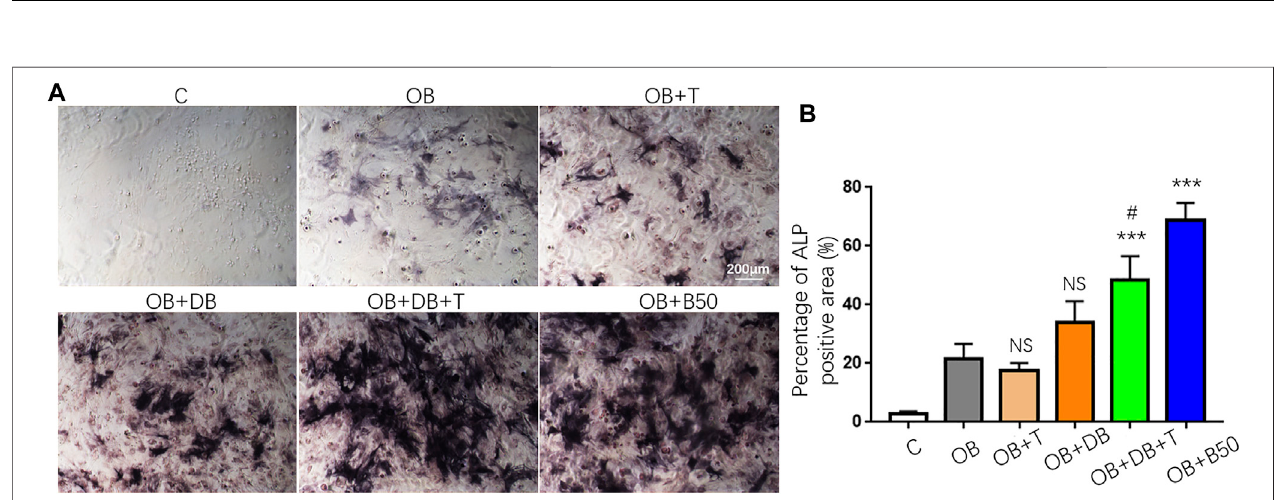
FIGURE6| SynergisticosteogenesiseffectofDOPA 4 @BMP2p coatingandTregcells. (A) RepresentativeimagesofALPstainingofrBMSCsculturedinadifferent medium. (B) Percentage of ALP staining positive area (%). Data are presented as the mean ± SD, n (cid:2) 4. Statistically signi fi cant differences are indicated by *** p < 0.001 compared with the OB group (OB), and NS means not statistically signi fi cant. # p < 0.05 compared with the OB + DB group. Abbreviations: C (control), OB (osteogenic induction medium), OB + T (conditional medium consist of OB medium and supernatant from Treg induction group), OB + DB (conditional medium consist of OB medium and supernatant from DOPA 4 @BMP2p group), OB + DB + T (conditional medium consist of OB medium and supernatant from Treg induction + DOPA 4 @ BMP2p group), and OB + B (OB medium plus 50 ng/ml BMP2p).